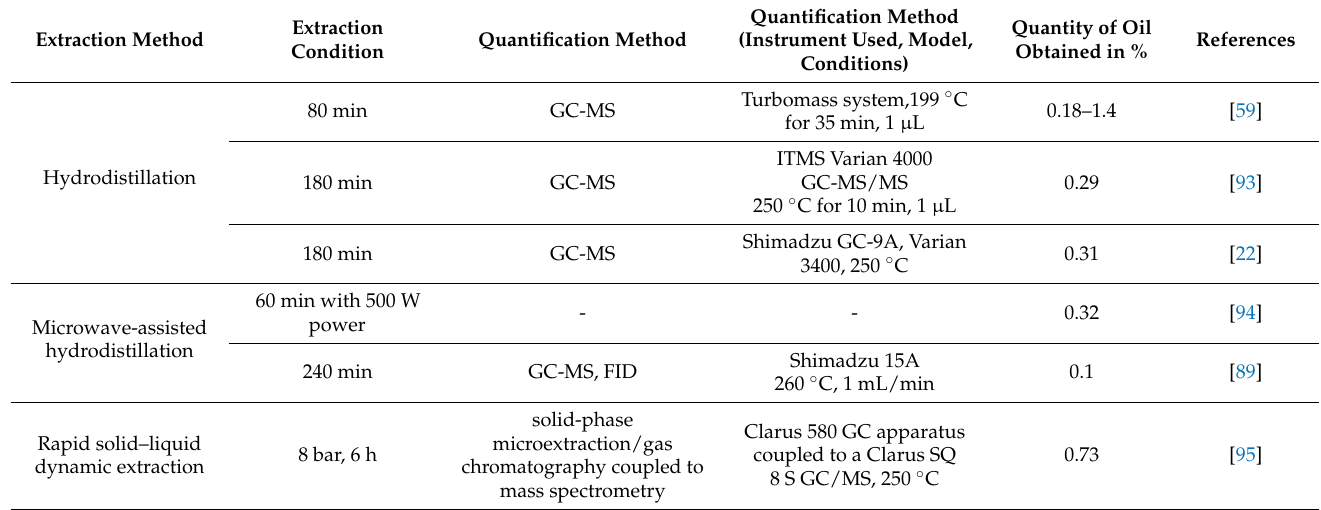
Table 5. Extraction and analysis of EO in